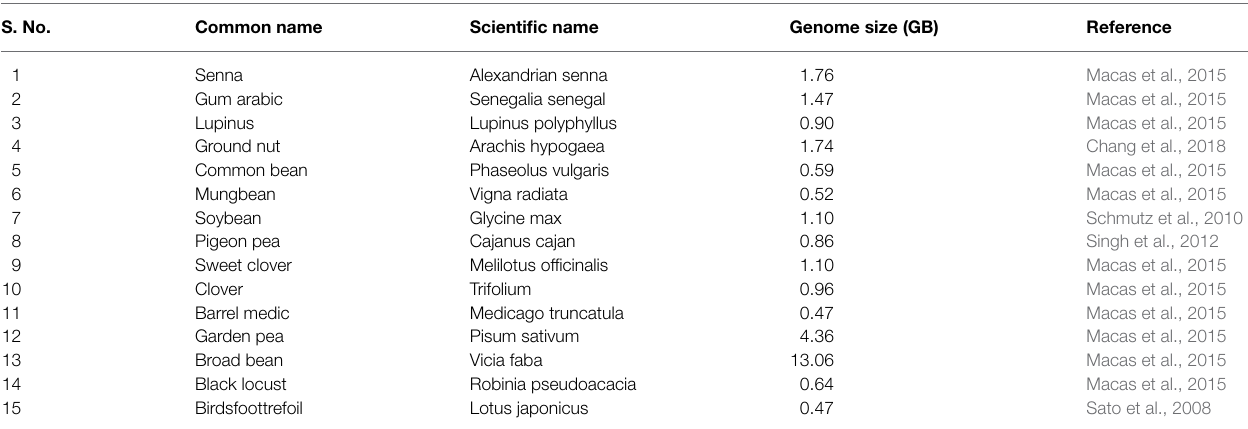
TABLE 1 | Available genome size of various legumes along with scientific name. S. No.